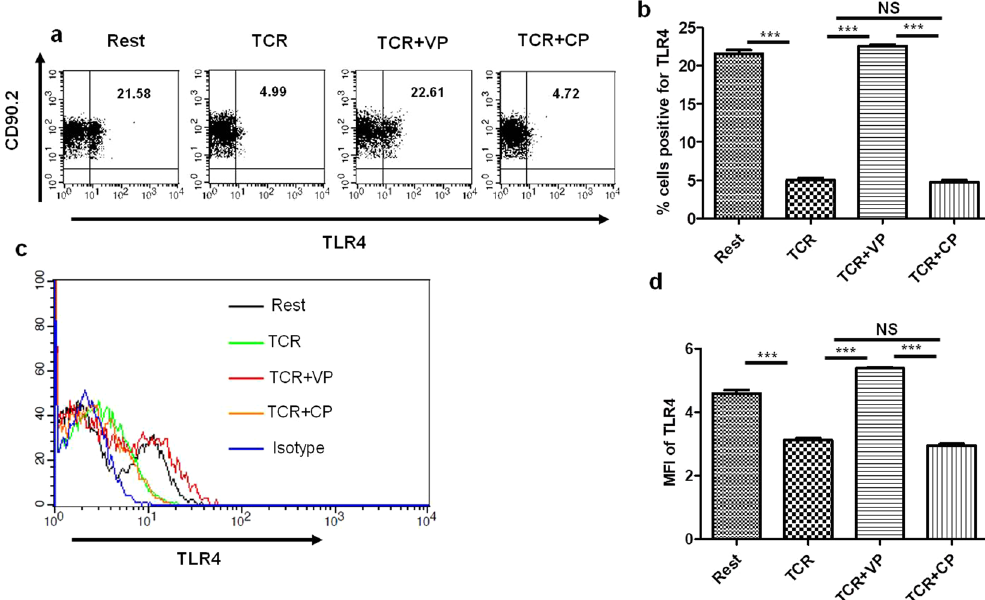
Figure 2. Differential surface expression of TLR4 during T cell activation. ( a ) Flow cytometry dot plot showing frequency of T cells (% positive cells) expressing TLR4 is significantly reduced during TCR mediated T cell activation and VIPER treated cells showed restoration of TLR4 expression. ( b ) Bar graphs showing % positive cells expressing TLR4 from three independent experiments. ( c ) MFI plot showing TLR4 MFI is reduced in TCR activated cells whereas VIPER treated cells show restoration of TLR4 expression. ( d ) Bar graph representing MFI data of TLR4 expression from three independent experiments. Data shown are representative of